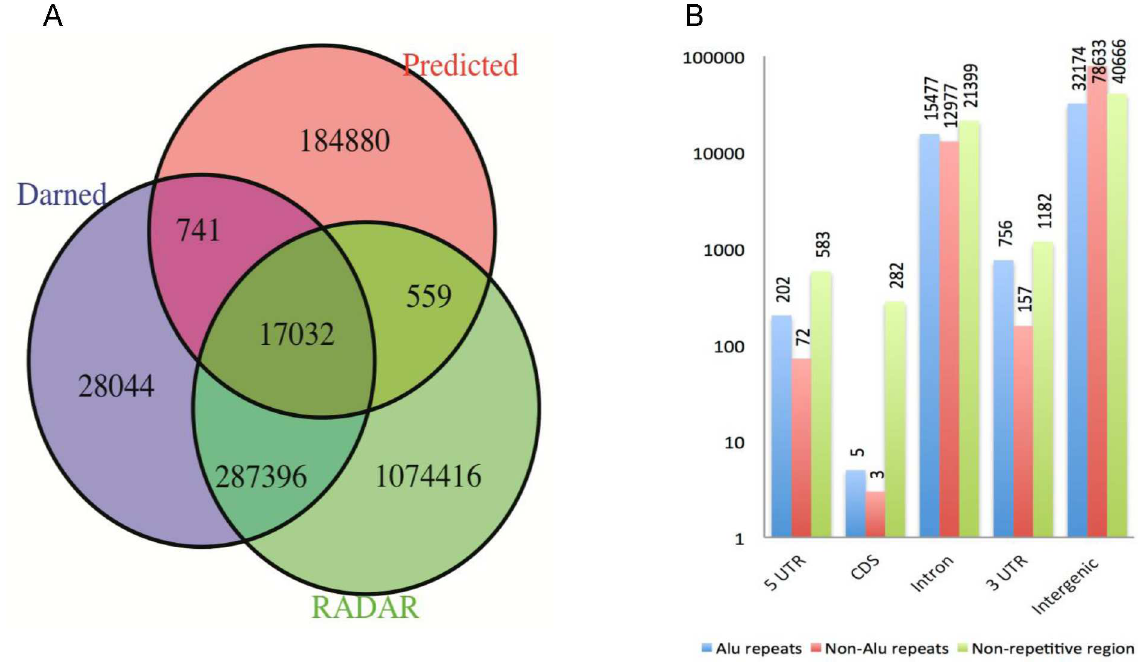
Fig 4. The putative A-to-I RNA editing events. (A) Overlap between the predicted RNA editingevents (red) with Darned(blue) and RADAR (green). Notice that RADAR only collects A-to-I RNA editingevents. (B) The genomic distribution of predicted RNA editing events. The genomic regions are annotatedby UCSC known genes and repeat masker (hg19, http://genome.ucsc.edu/). One genome coordinate position may have multi- annotations. 5’ UTR: 5’ untranslated regions. 3’ UTR: 3’ untranslated regions. CDS: codingregion of a gene. Intergenic: intergenic region. Alu repeat: a short stretch of DNA originally characterized by the action of the Arthrobacter luteus restriction